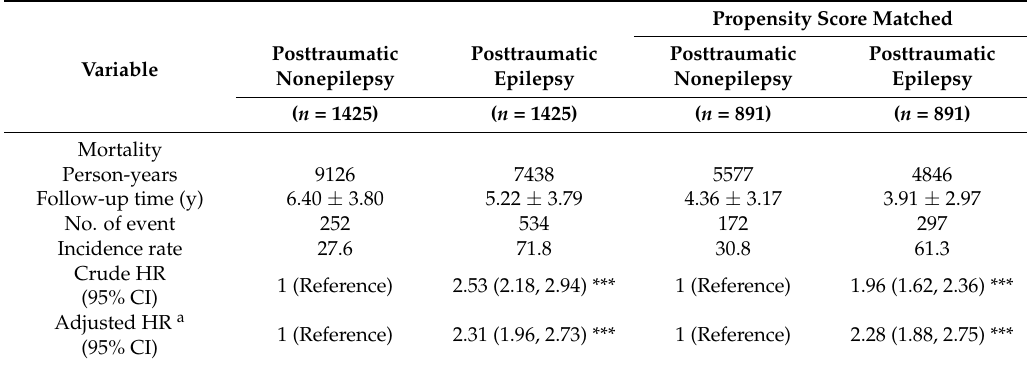
Table 2. Overall incidence (per 1000 person-years) and hazard ratio of mortality with and without propensity-score matching between the PTE and PTN